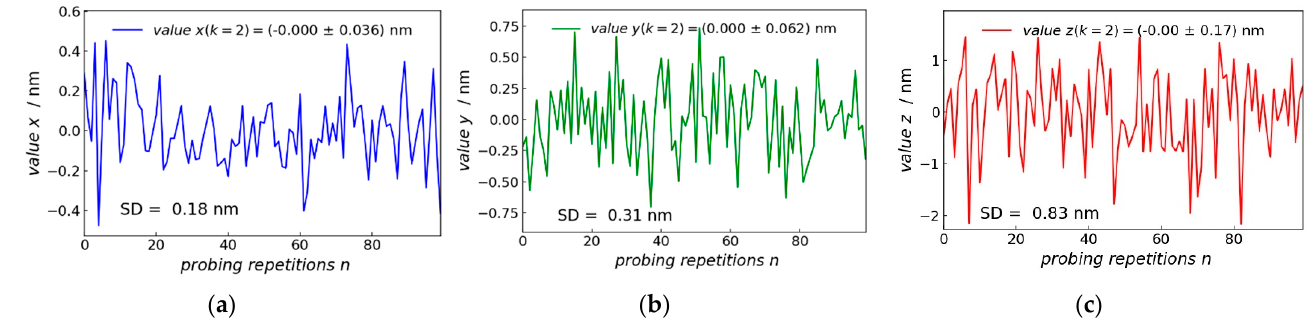
Figure 10. Measurement repeatability: 100 times probing on the same spot on the rigid bulk material of an IVPS100-PTB structure in ( a ) x-, ( b ) y-, and ( c ) z-direction, x- and y-coordinate are probed on the sidewall (SD = standard